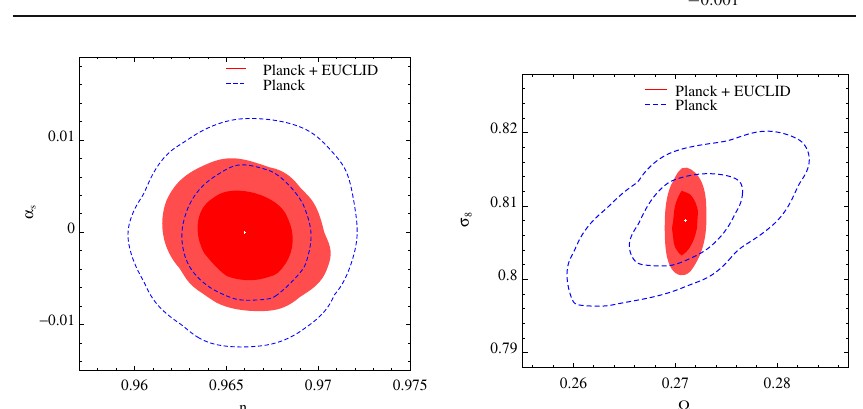
Fig. 52 The marginalized likelihood contours (68.3 and 95.4% CL) for Planck forecast only (blue dashed lines) and Planck plus Euclid pessimistic (red filled contours). The white points correspond to the fiducial